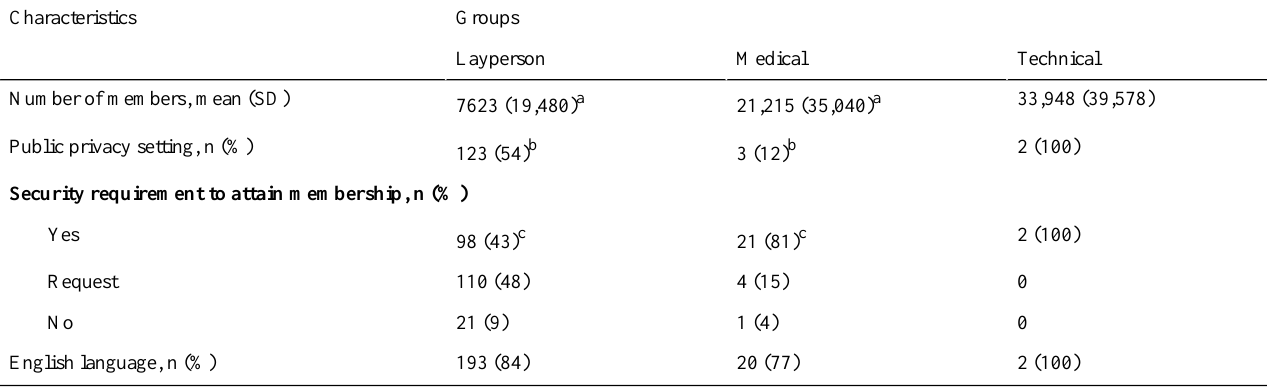
Table 3. Characteristics of layperson, medical, and technical groups.